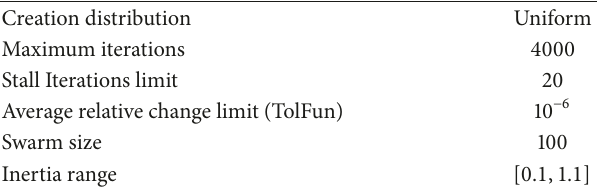
Table 6: PSO configuration parameters.